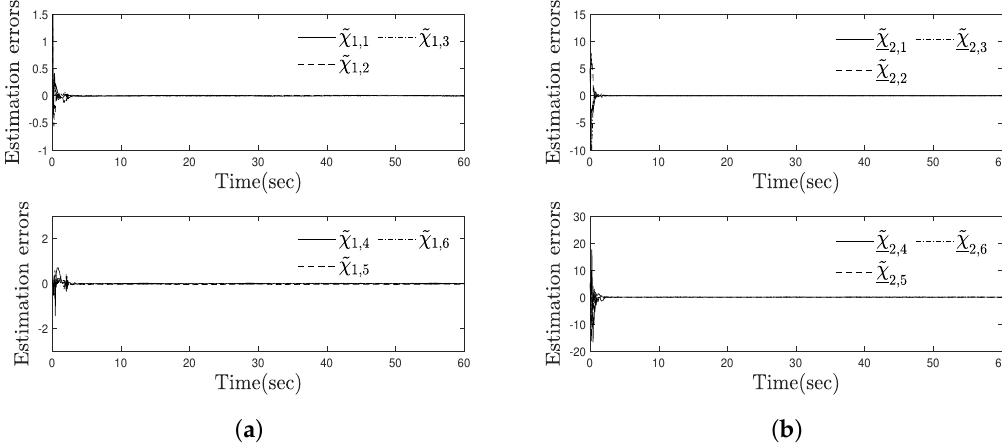
Figure 5. State estimation errors of the proposed approach for Scenario 1 ( a ) ˜ χ 1,1 , ˜ χ 1,2 , ˜ χ 1,3 , ˜ χ 1,4 , ˜ χ 1,5 , and ˜ χ 1,6 ( b ) ˜ χ ˜ χ , ˜ χ , ˜ χ , and ˜ χ 2,3 2,4 2,5 2,6